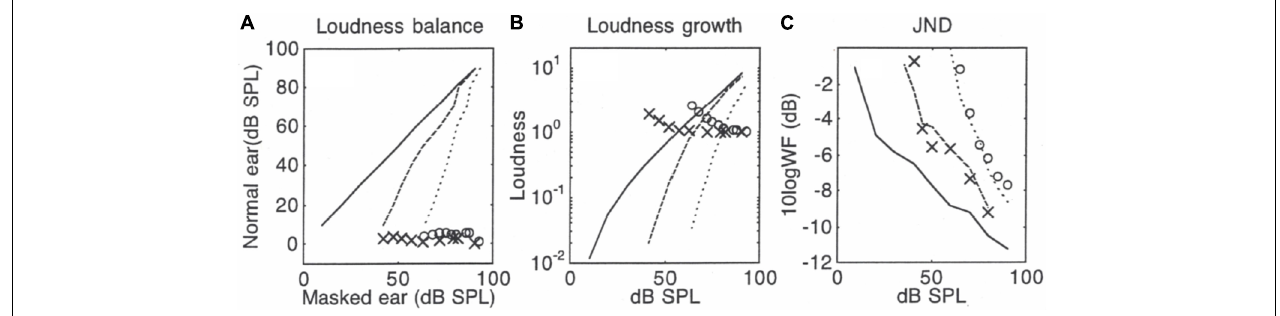
FIGURE 1 | Predictions in simultaneous masking, with data (lines) being from Schlauch et al. (1995). Panel (A) shows loudness balance functions between a tone in quiet ( y -axis) and a tone in noise ( x -axis): The solid line represents the control condition where the same tone was balanced between the two ears in quiet, the dashed line represents the balance function for a tone being masked by a 15-dB SPL/Hz broadband noise, and the dotted line represents the loudness balance function for a tone by a 40-dB SPL/Hz noise. The symbols represent slope values for the balance function. The slope values use the same scale as the balance function from 0 to 100, except the slopes are unitless. Panel (B) shows derived loudness growth functions. The symbols represent loudness ratio values between quiet and masked tones and tones in quiet. Panel (C) shows the measured jnd functions (lines) and predicted jnd values (symbols).